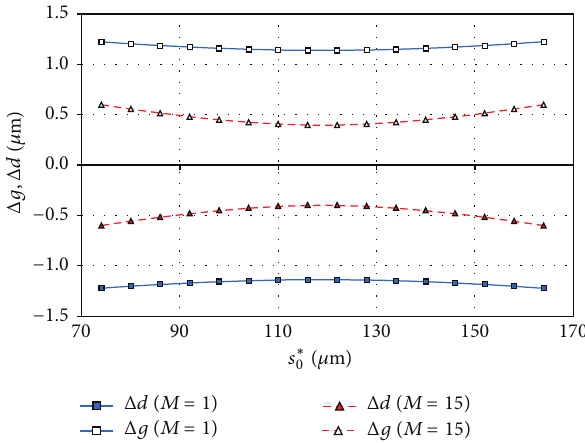
Figure 4: Calibration uncertainties for air gauges with measuring